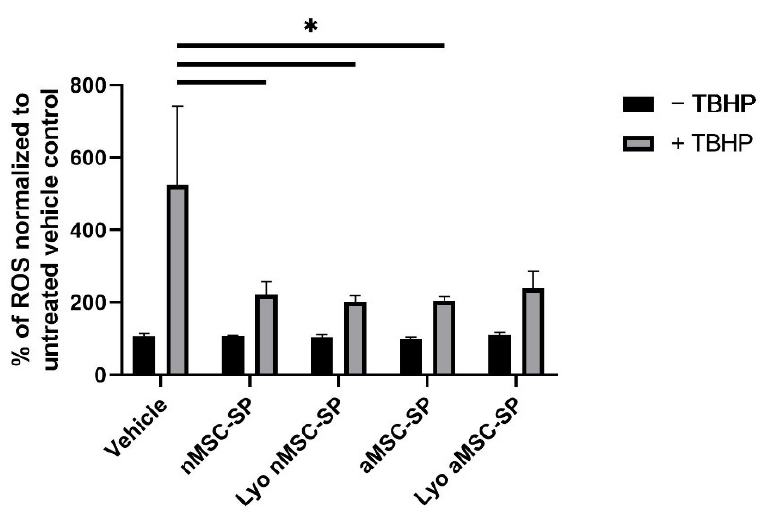
Figure 2. Antioxidant effects elicited by MSC-SP are maintained post-lyophilization. To alter the composition of the MSC-secretome product, MSC were exposed to normoxia or anoxia. The secretome products were isolated from the normoxic (nMSC-SP) or anoxic (aMSC-SP) preconditioned MSC by tangential flow filtration and separated into equal-volume aliquots. One aliquot of each sample was lyophilized using the manifold protocol (Lyo). HepG2 cells were pre-treated with 8.00 × 10 8 particles of fresh or 1.00 × 10 10 particles of lyo nMSC-SP or aMSC-SP for 24 hr. After this, half the cells in each treatment condition were exposed to 0.5 mM TBHP for 1 hr. A DCFDA assay was performed to quantify the levels of reactive oxygen species (ROS). (*) represents p <